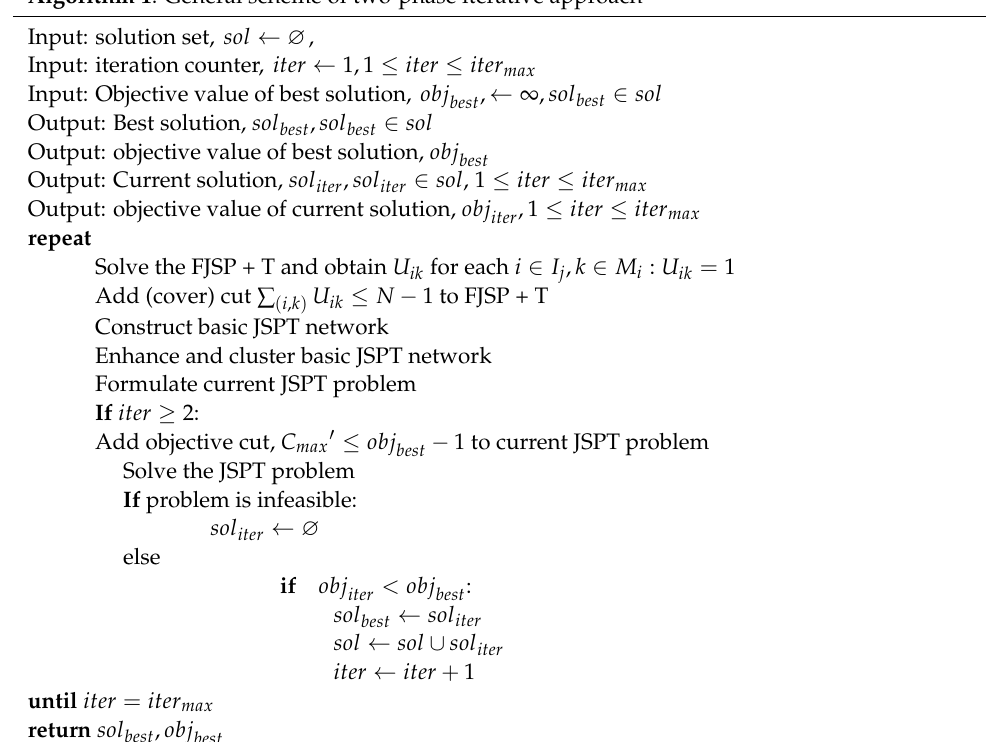
Algorithm 1 : General scheme of two-phase iterative